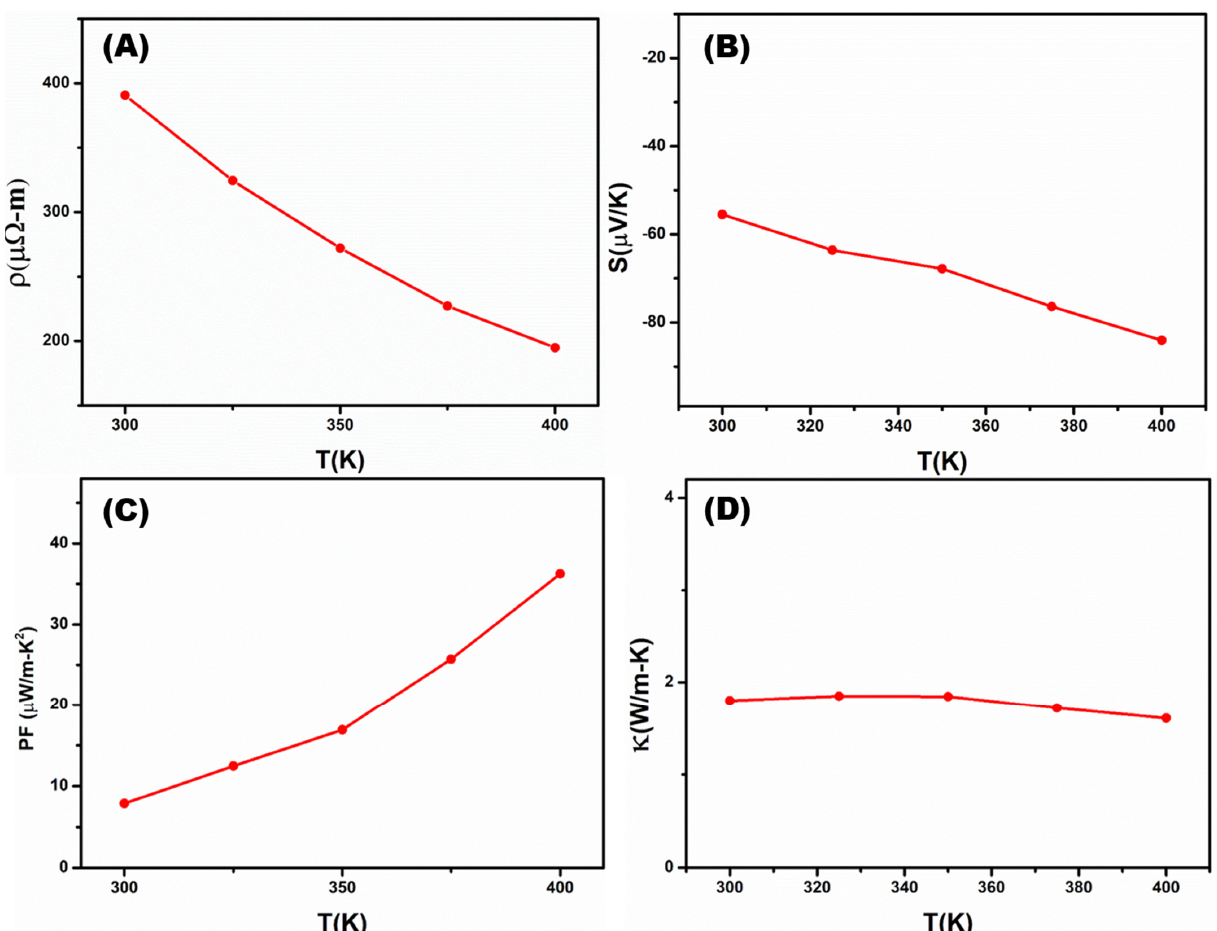
Figure 7. Resistivity ( A ), Seebeck coefficient (B ), power factor ( C ), and thermal conductivity ( D ) of InSb P ‐ NWs as a function of temperature. InSb P-NWs as a function of